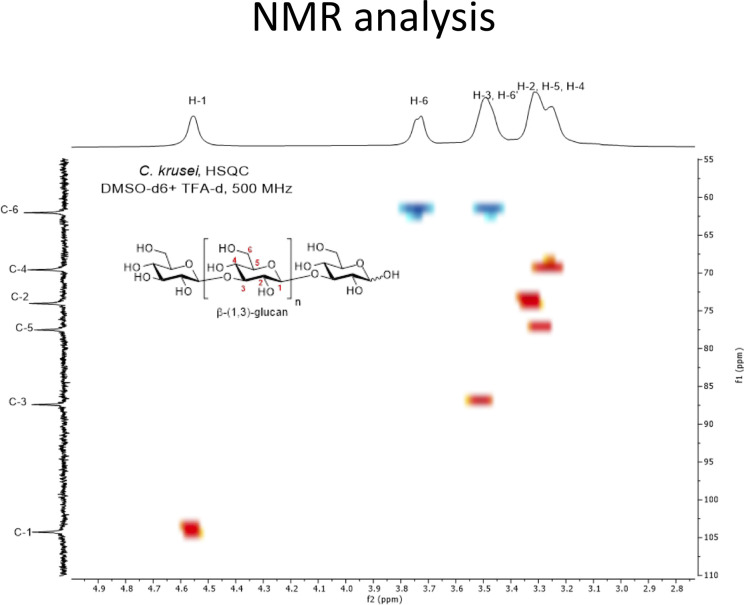
HSQC spectrum of C. krusei β-glucan (500 MHz, DMSO-d6 + TFA-d1). C. krusei β−glucan 50 mg was dissolved in DMSO-d6 (2.07 ml) and TFA-d1 (0.11 ml) then 0.5 mL of the solution was withdrawn to perform the HSQC experiment with 500 MHz NMR spectrometer at room temperature. The spectrum indicated a highly homogeneous β-(1,3)-glucan without β-(1,6)-branching.